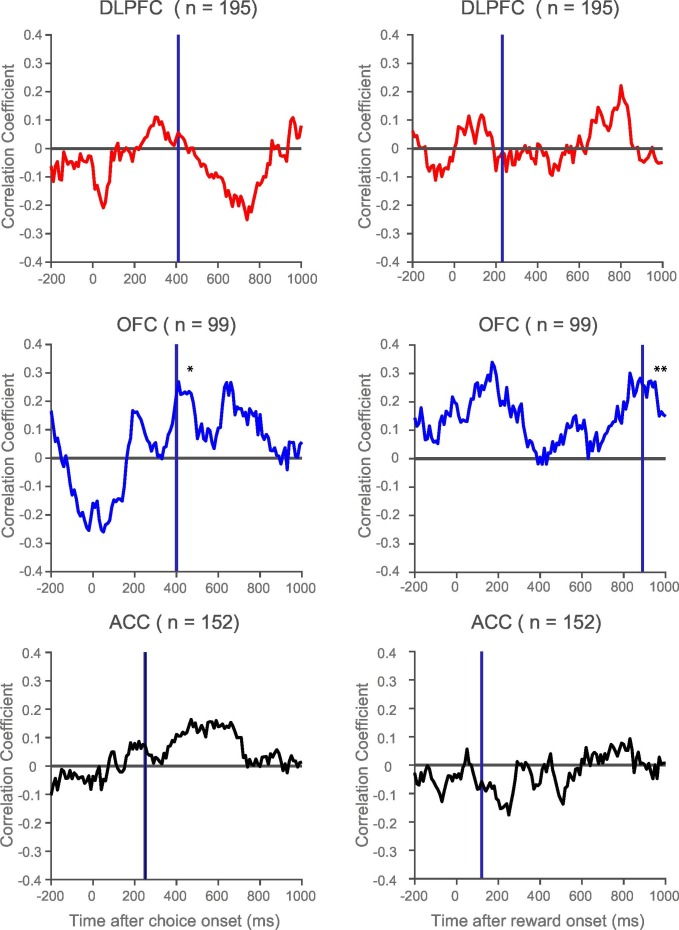
Rank correlation between resting time constant and chosen value correlates during choice and following reward.Within the orbitofrontal cortex (OFC), there was a positive correlation between resting time constant and the coefficient of partial determination (CPD) for chosen value at the time of the maximum population-average CPD during choice (vertical purple line, correlation coefficient = 0.2268, p=0.0242) and outcome (vertical purple line, correlation coefficient = 0.2608, p=0.0093). This effect was also present shortly after the onset of reward delivery. The relationship between resting time constant and chosen value correlates was weaker within the dorsolateral prefrontal cortex (DLPFC) and anterior cingulate cortex (ACC) at choice. Towards the end of the decision phase, when DLPFC transitions between primarily chosen value correlates to coding the chosen action (Hunt et al. 2015), a negative correlation between resting time constant and chosen value CPD emerges. There was no relationship between time constant and the chosen value coding within DLPFC and ACC at the time of outcome. * represents p<0.05; ** represents p<0.01.